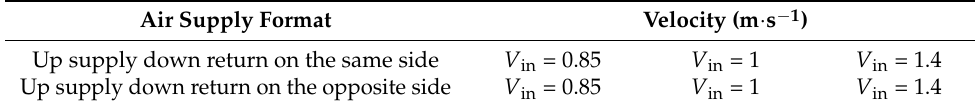
Table 4. Numerical simulation conditions and contents under air-conditioning.